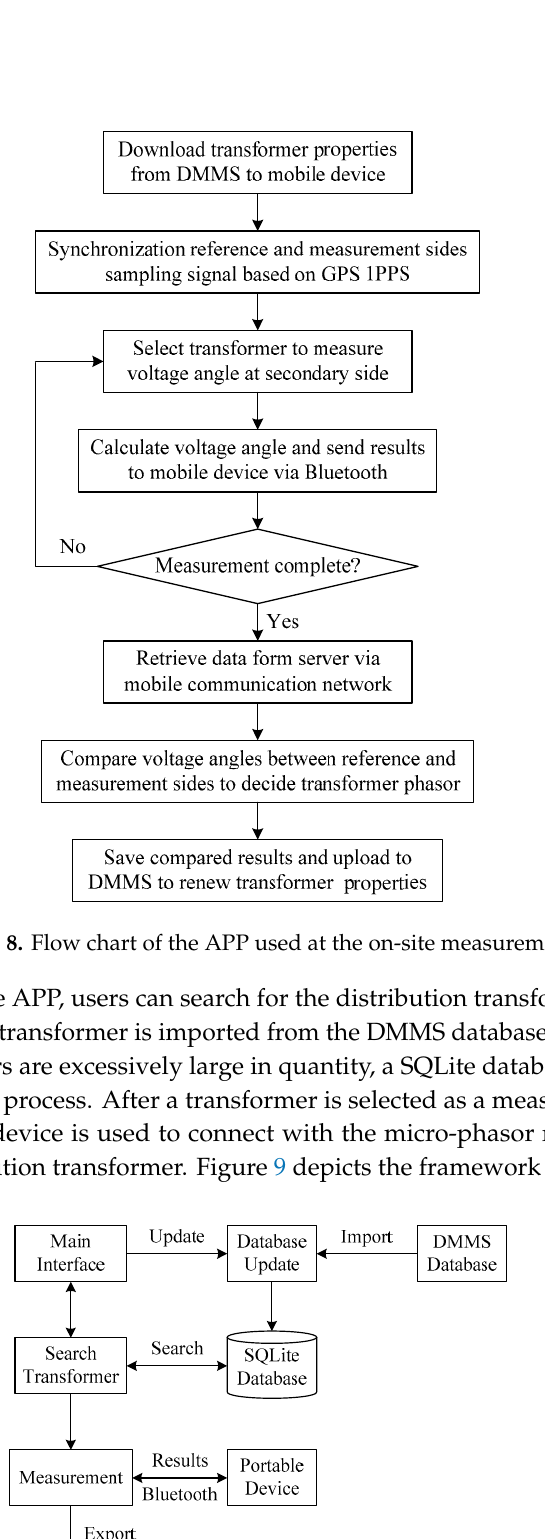
Figure 9. The framework of the APP. Figure 10. The framework of the phasor comparison.